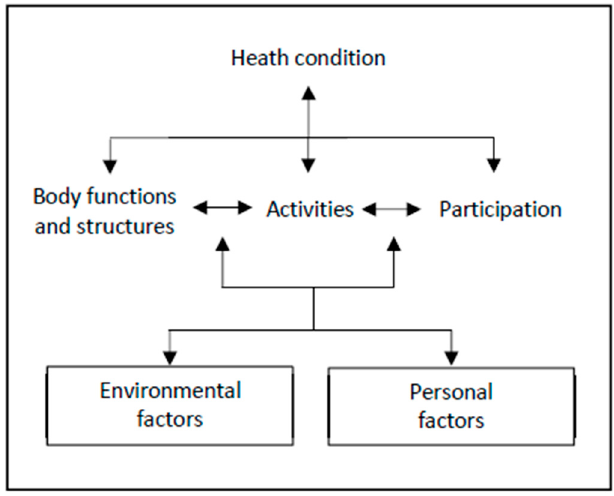
Figure 1. World Health Organisation International Classification of Functioning (ICF) [1].